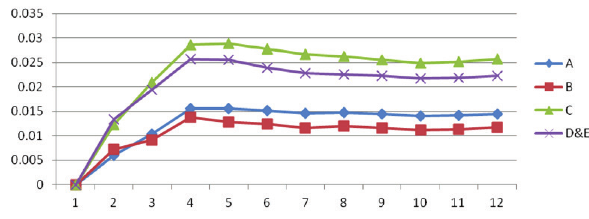
Figure 9d. Accumulated impulse response of PRI to shocks in